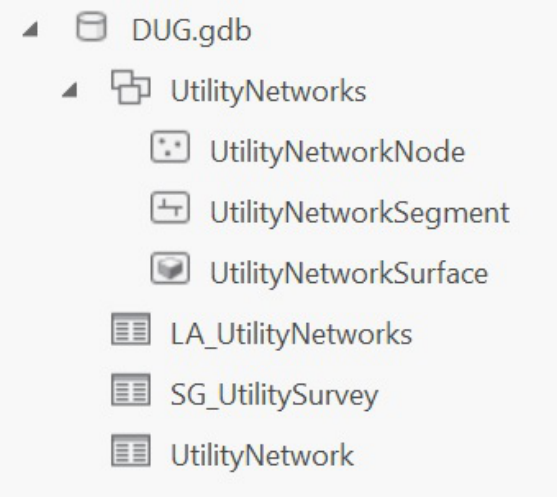
Figure 10. Underground utility database structure.